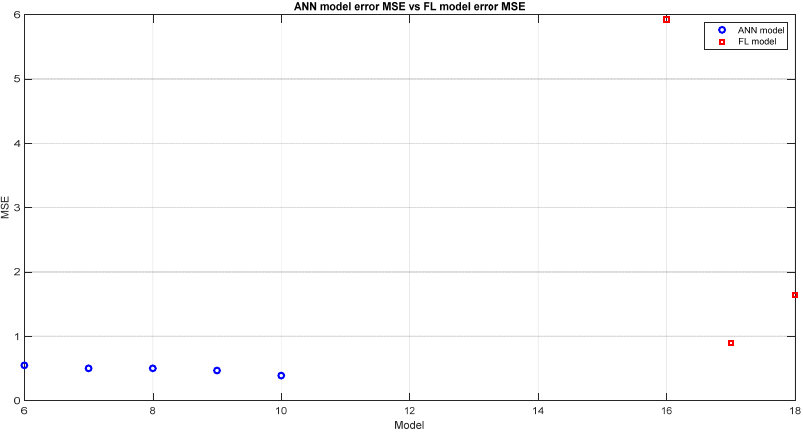
Figure 17. Comparison of ° Brix prediction models.